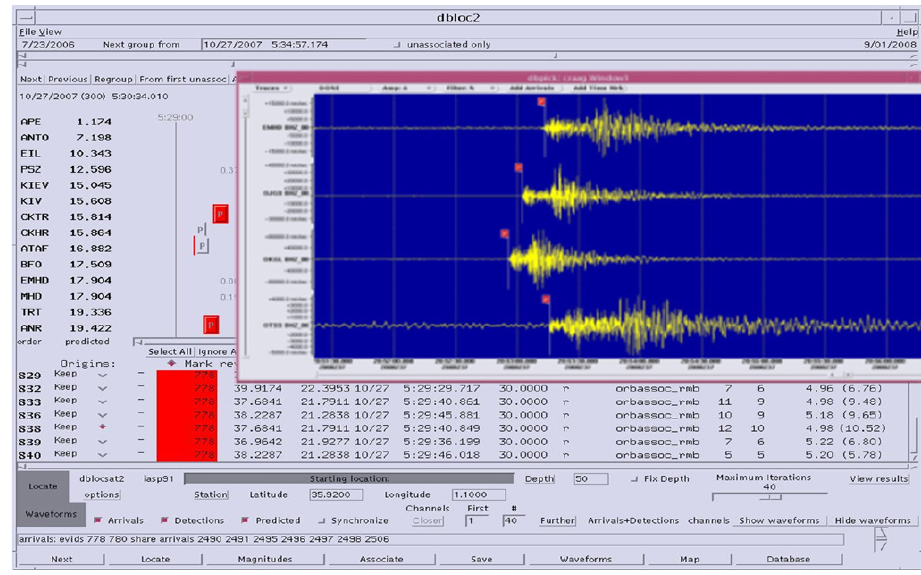
Fig. 7. Manual processing with Antelope reviewing the different parameters of the seismic event.